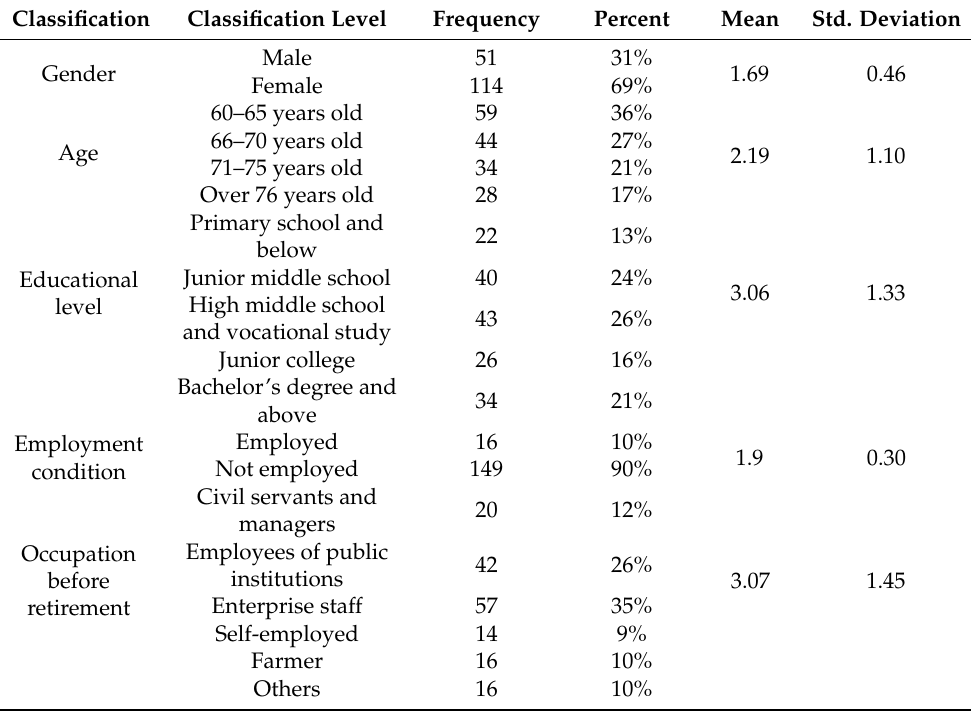
Table 1. Descriptive characteristics of the sample ( n =